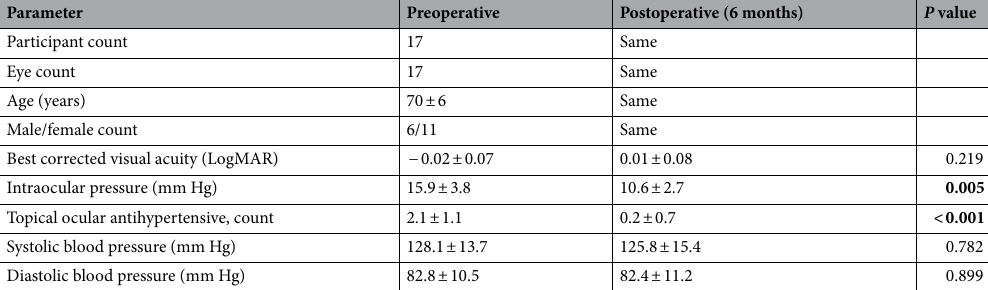
Table 1. Participant characteristics. MD mean deviation, PSD pattern standard deviation, NFL nerve fiber layer, NFLP-CD retina nerve fiber layer plexus capillary density. Group means ± standard deviations are shown unless otherwise noted. The Wilcoxon signed rank test was used. Statistically significant P values (< 0.05) are in bold type. For the count of topical anti-ocular hypertensives, combination agents are counted as 2 medications.